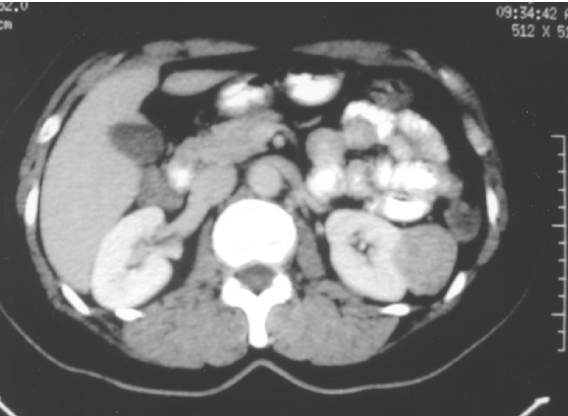
Figure 2 – Histopathological study demonstrating renal pleo- morphic liposarcoma. Neoplastic tissue of mesenchymal origin, spindle and oval cells with abundant cytoplasm, hyperchromic nuclei and intense pleomorphism (HE,